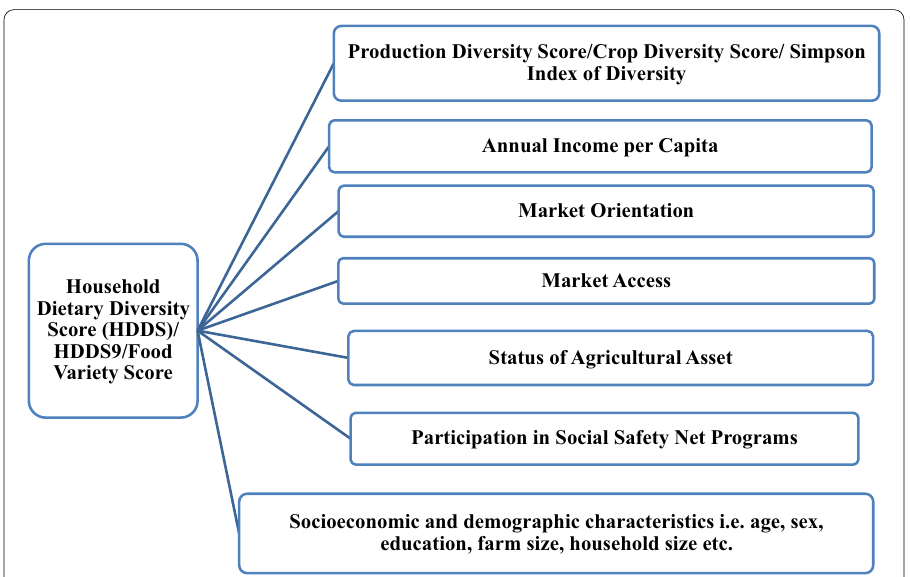
Fig. 2 Framework showing outcome and independent variables used in the